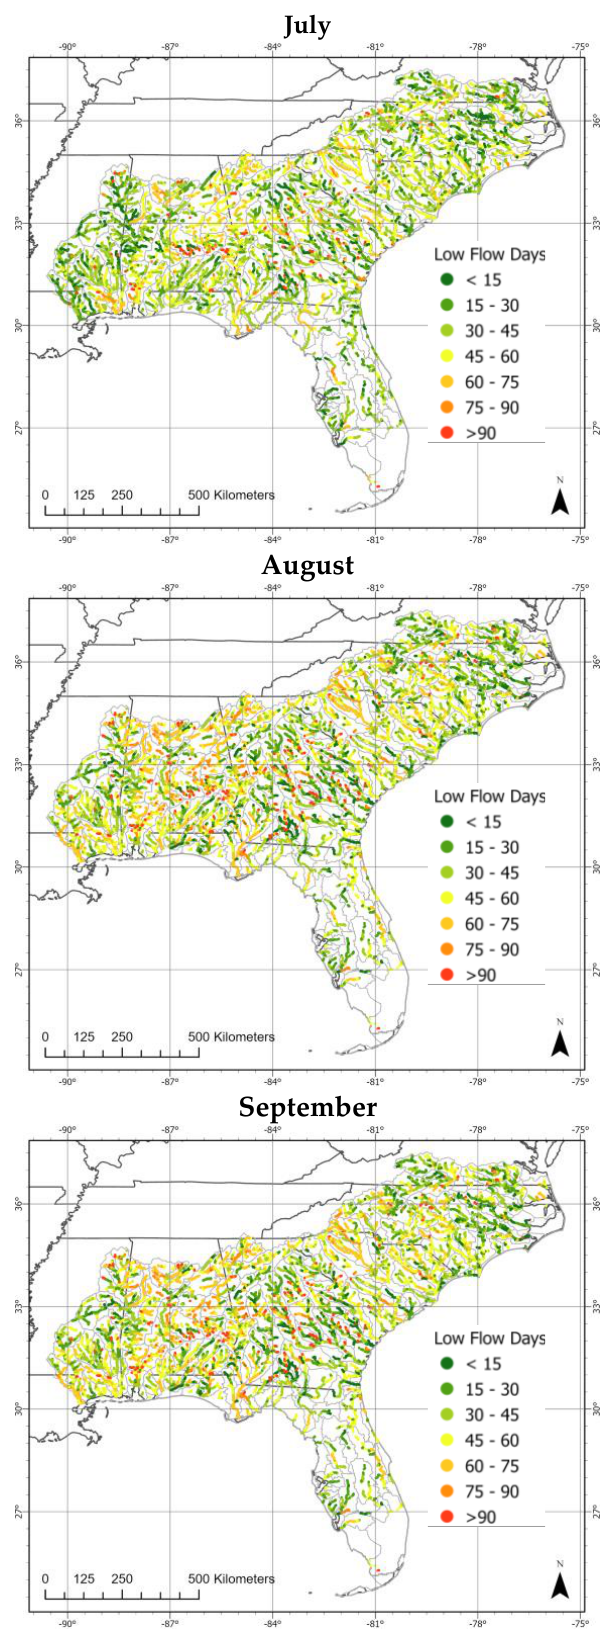
Figure 6. Warm season (July – September) patterns of low flow frequency (total number of 7Q10 days) over the study region based on NWM retrospective simulations.